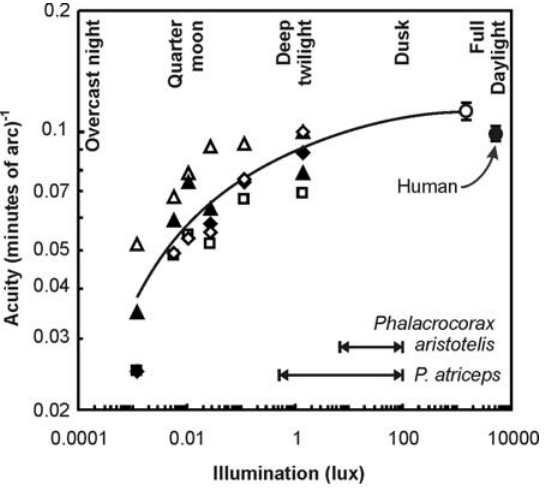
Figure 1. Effect of ambient illumination (lux) on the visual acuity of five great cormorants Phalacrocoraxcarbo. Visual acuity is expressed as the reciprocal of minutes of arc. The relationship is significant: log(acuity)= 2 0.00168 log(illumination) 2 + 0.0125 log(illumination) + 0.0889. Symbols represent individual birds: m , n , X , e , % . Mean values 6 SEM: 0.034 6 0.006, 0.055 6 0.004, 0.063 6 0.005, 0.064 6 0.007, 0.077 6 0.006, 0.087 6 0.006 for illuminations of 0.0012, 0.0058, 0.011, 0.028, 0.11, and 1.4 lux, respectively. # =mean data 6 SEM for five great